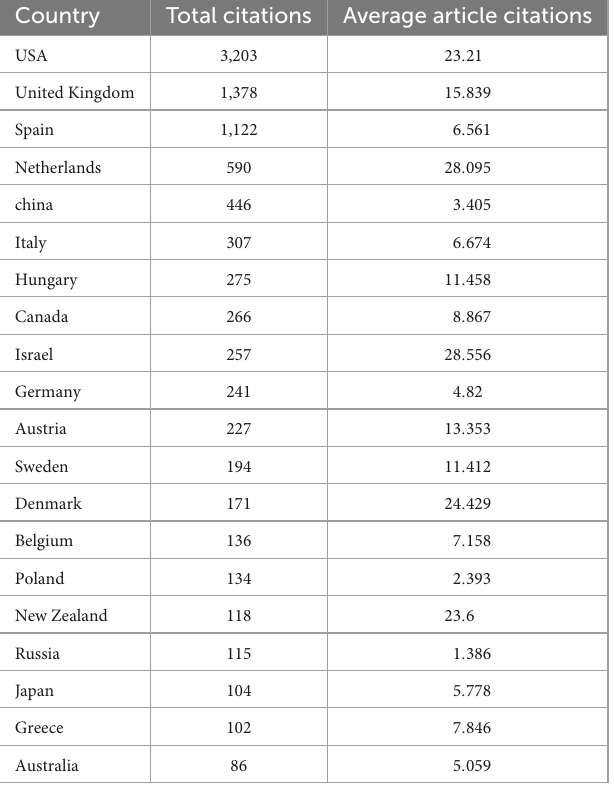
TABLE 2 Most cited